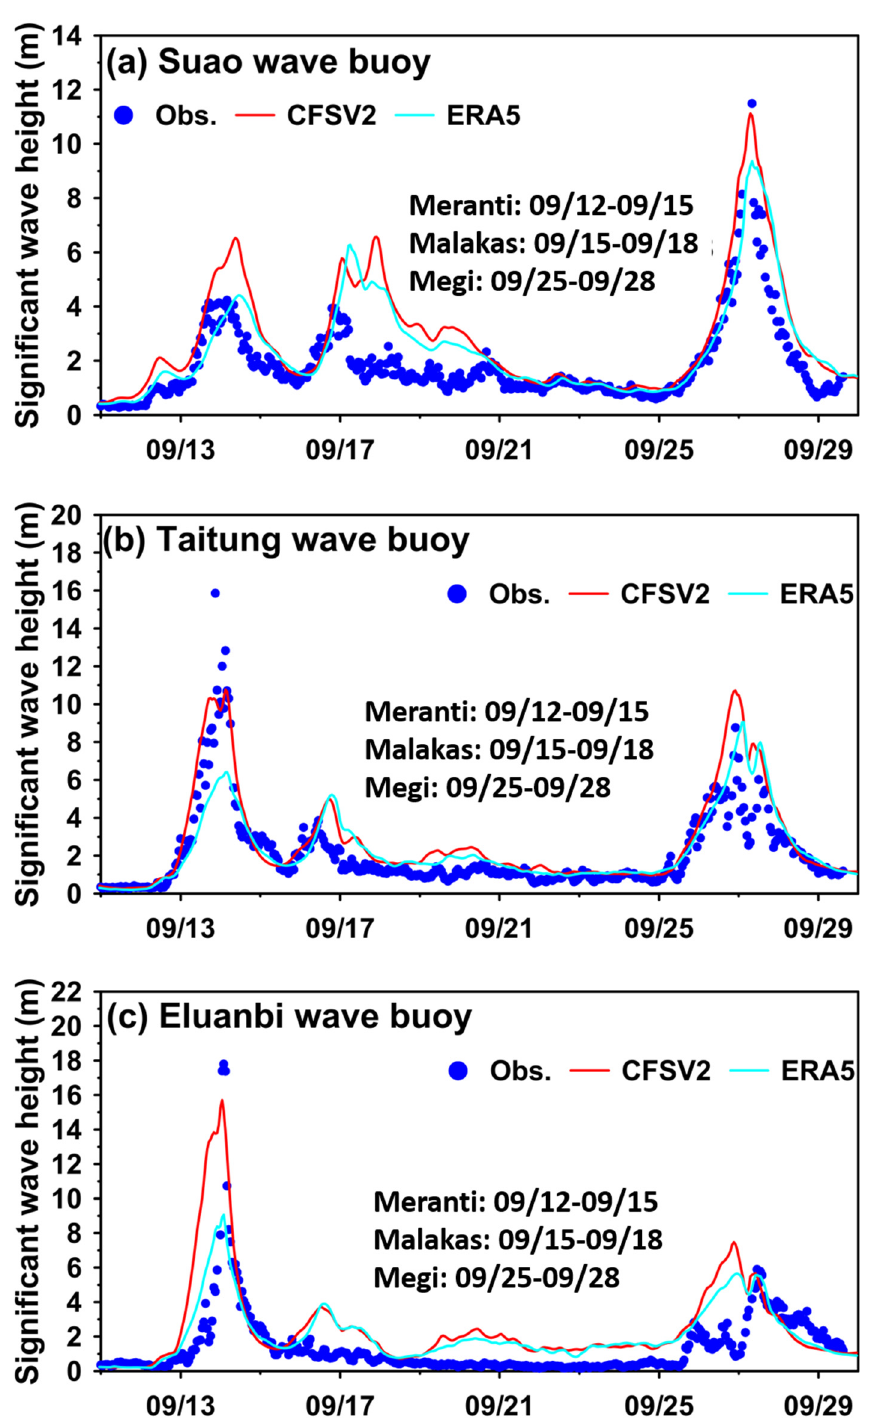
Figure 3. Comparison of the hourly significant wave heights between simulations and measurements for the ( a ) Suao, ( b ) Taitung, and ( c ) Eluanbi wave buoys in September 2016.